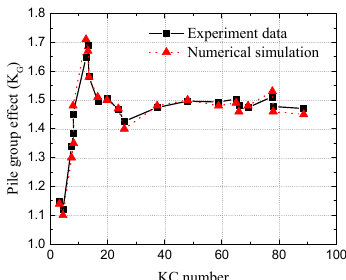
Figure 4. Variations of the pile group effect K G versus different KC numbers for the side-by-side arrangement with S G / D = 1. Challenges 2017 , 8 , 30